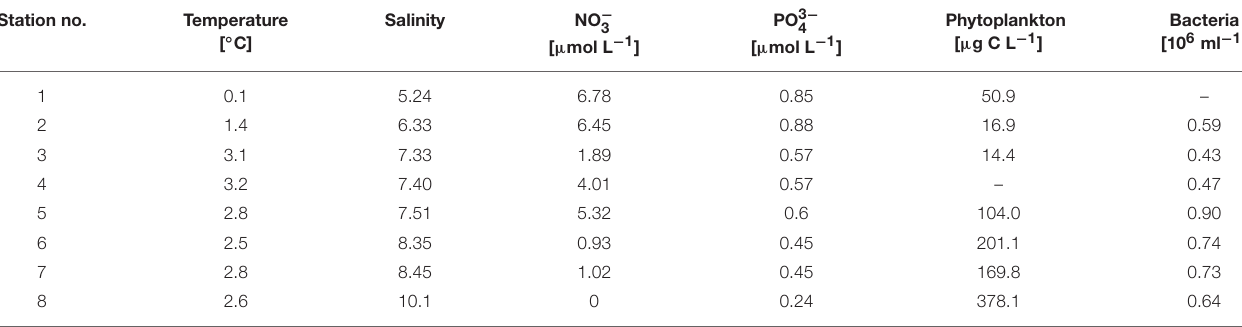
TABLE 1 | Overview of the baseline parameters for all sampled stations in the Baltic Sea. Station